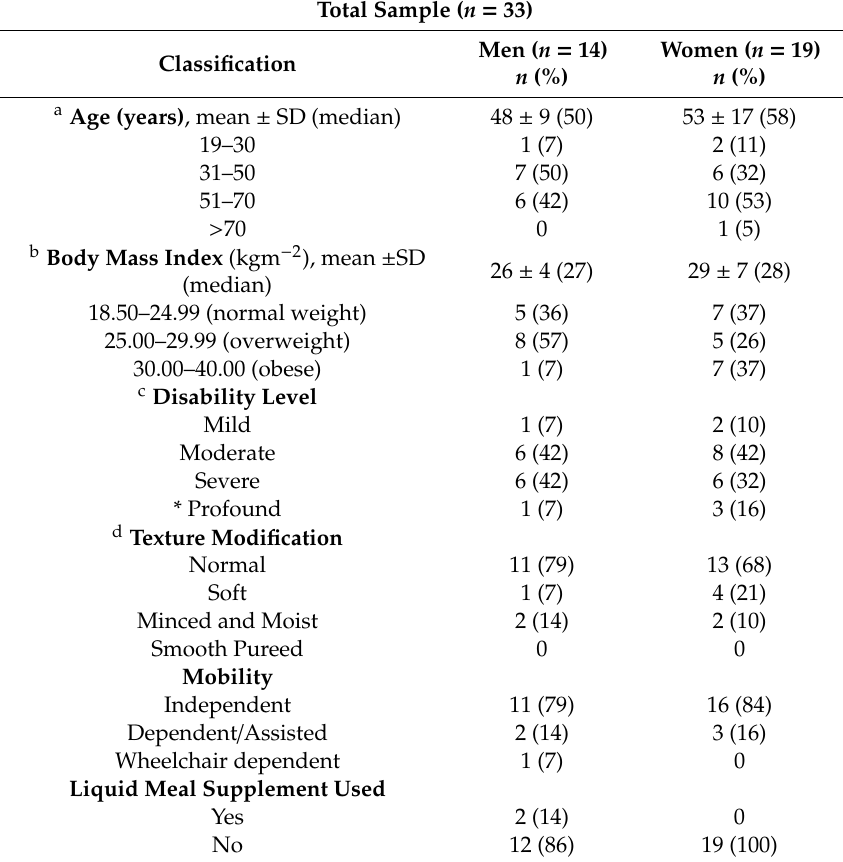
Table 1. Demographic characteristics of participants. Total Sample ( n =